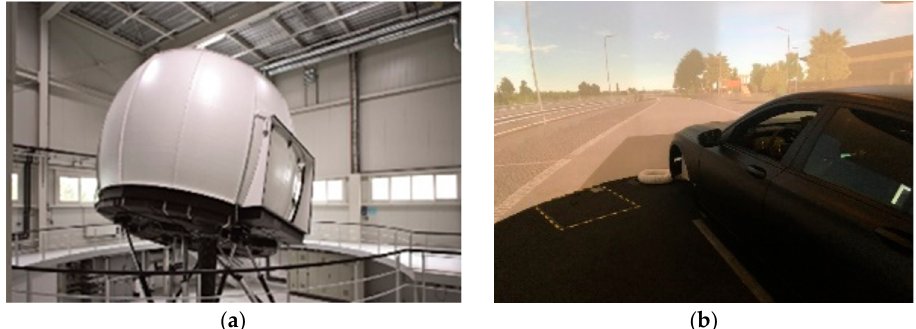
Figure 1. Moving-base driving simulator from the outside ( a ) and inside mockup used in the current study ( b ). study ( b